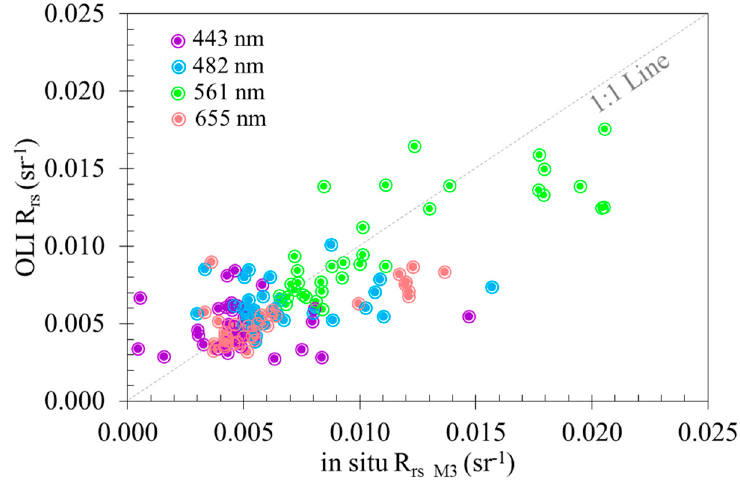
Figure 7. Comparison between OLI derived R rs and in situ R rs using 34 sampling spots.